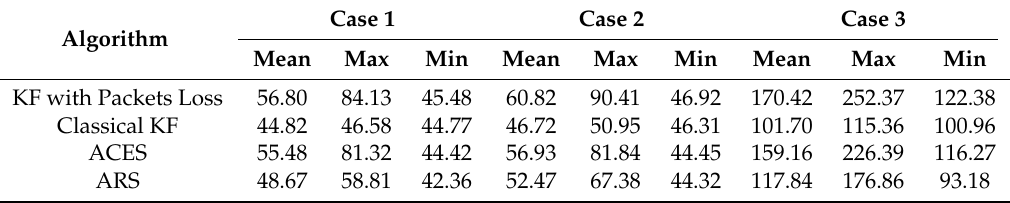
Table 2. Comparison of clock error statistics results of different algorithms ( µ s).